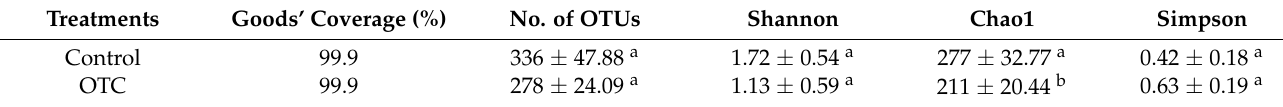
Table 1. Diversity indices of studied rainbow trout gut samples.